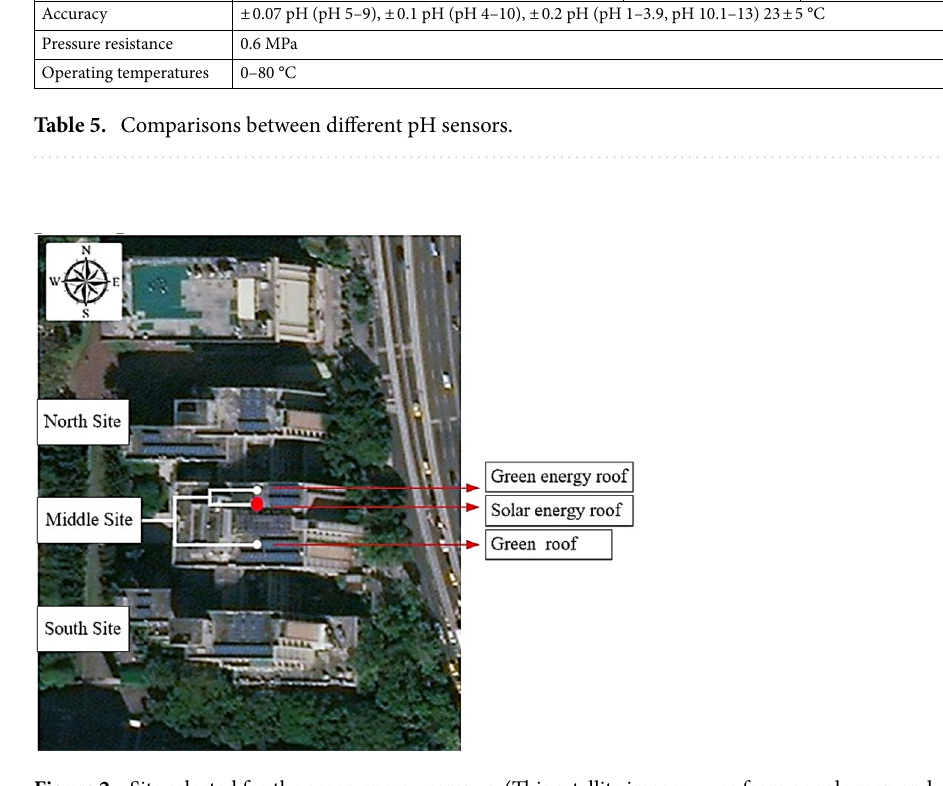
Figure 2. Site selected for the green energy campus. (This satellite imagery was from google map and was modified by adding the words on